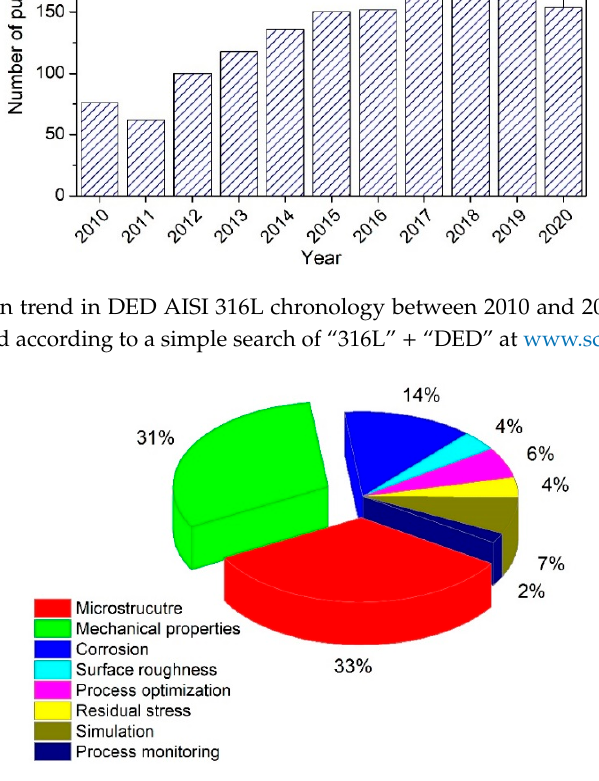
Figure 2. Pie chart showing the percentage of publications at www.sciencedirect.com on different features of the processing of AISI 316L via the DED process.